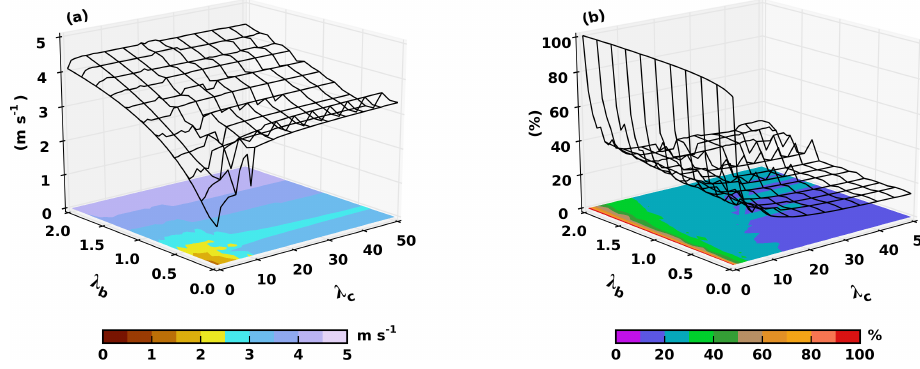
Figure 5. Similar to Fig. 4a, b but for an iterative upwards integration technique.